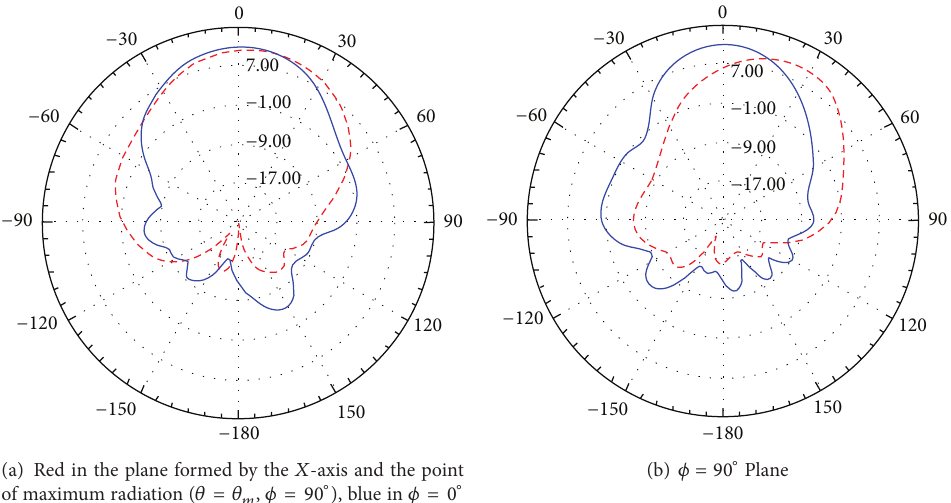
Figure 10: Simulated gain patterns computed using HFSS, with initial bevel-cut results shown in red (dashed) and proposed design results in blue.